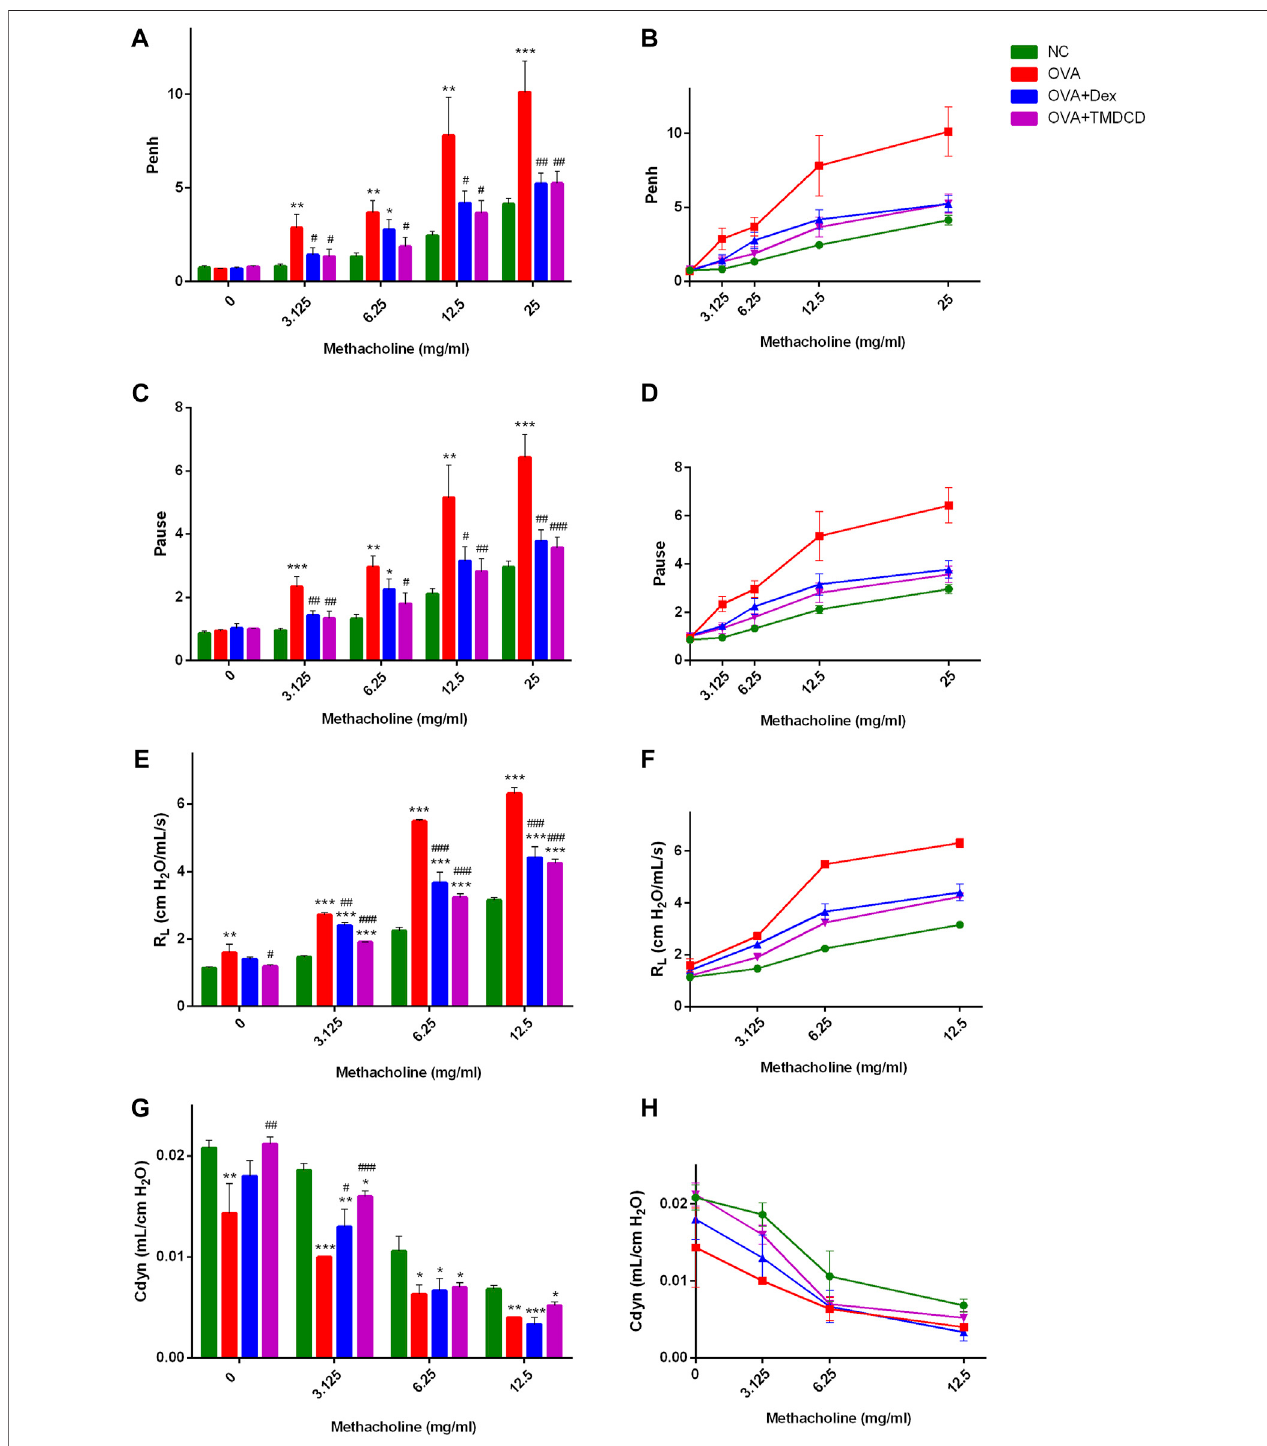
FIGURE 2 | Detection of AHR. (A, B) , after stimulation with MeCh, the difference and overall trend of Penh value among the groups. (C, D) , after stimulation with MeCh, the difference and overall trend of Pause value among the groups. (E, F) , the difference and overall trend of R L values among groups after MeCh stimulation. (G, H) , after stimulation with MeCh, the difference and overall trend of Cdyn values among groups. The results were expressed as Mean ± SEM, compared with NC group, * p < 0.05, * p < 0.01, * p < 0.001.Compared withOVA group, # p < 0.05, # p < 0.01, # p < 0.001. (WBPs: n (cid:2) 5 – 6 mice/group, RCs: n (cid:2) 3 – 5 mice/group. Theresults were from two independent